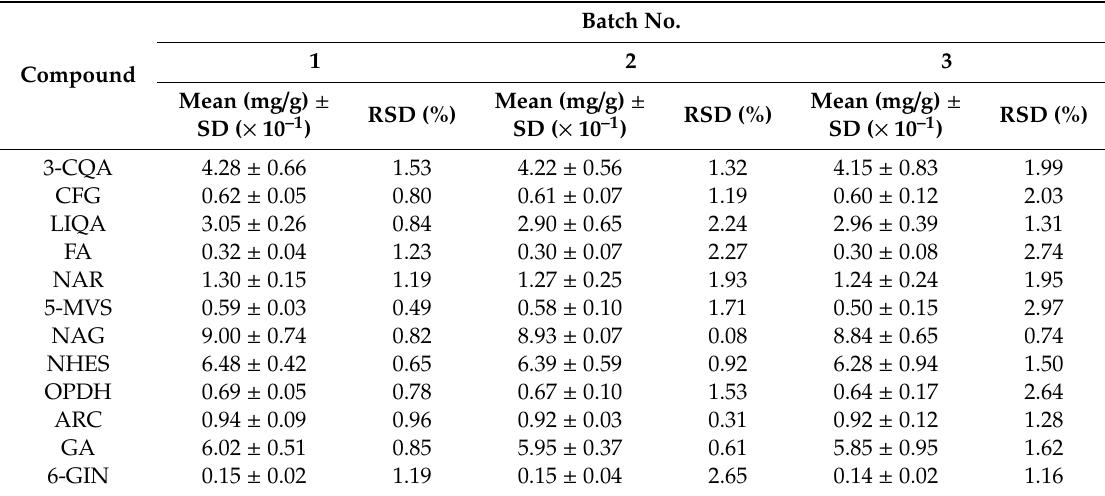
Table 4. Amount of the 12 marker components in YPS using HPLC–PDA (n = 3).